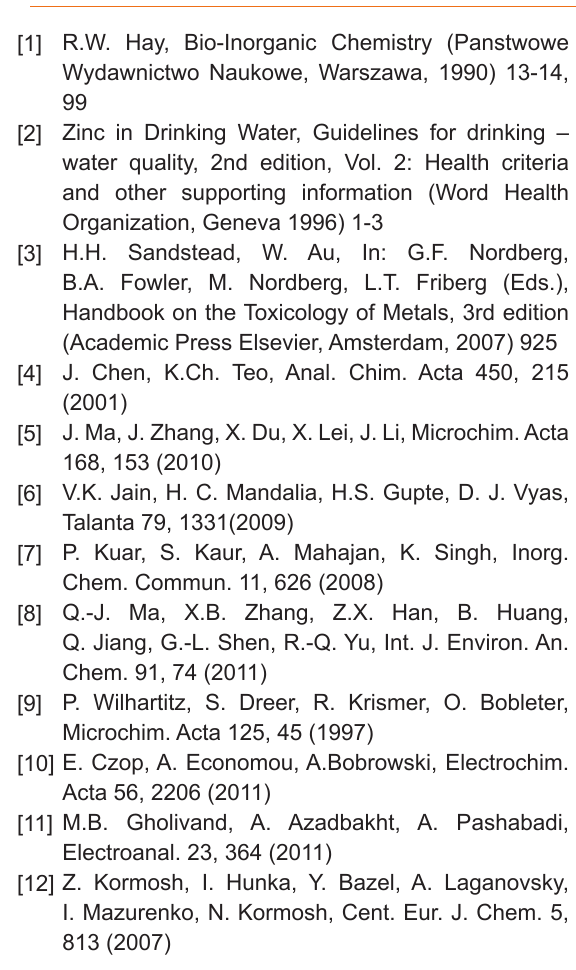
chloride ions, which in turn results in a short response time, good reproducibility, reversibility and stability of the electrode potential. The presented electrode has a simple construction in any shape, is easy to transport and works in every position. It may be used for zinc determination in the wide concentration range 3.0×10 -7 - parameters of proposed electrode are compared in Table 4 with other recently reported zinc-selective electrodes [52-58]. The data shows that the presented sensor is superior to other electrodes with regards to the detection limit, working concentration range and response time and it is comparable with regards to other